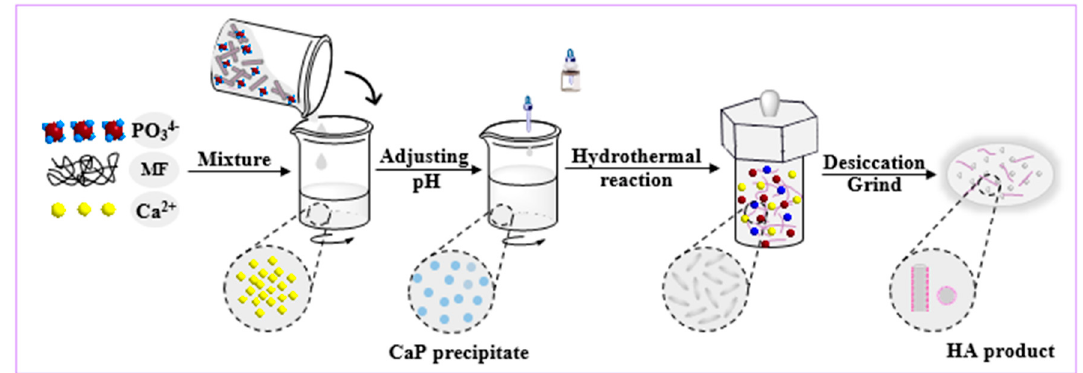
Figure 1. Schematic of processing strategies for the fabrication of mullite fiber (MF)/hydroxyapatite (HA) composite powders via hydrothermal method.